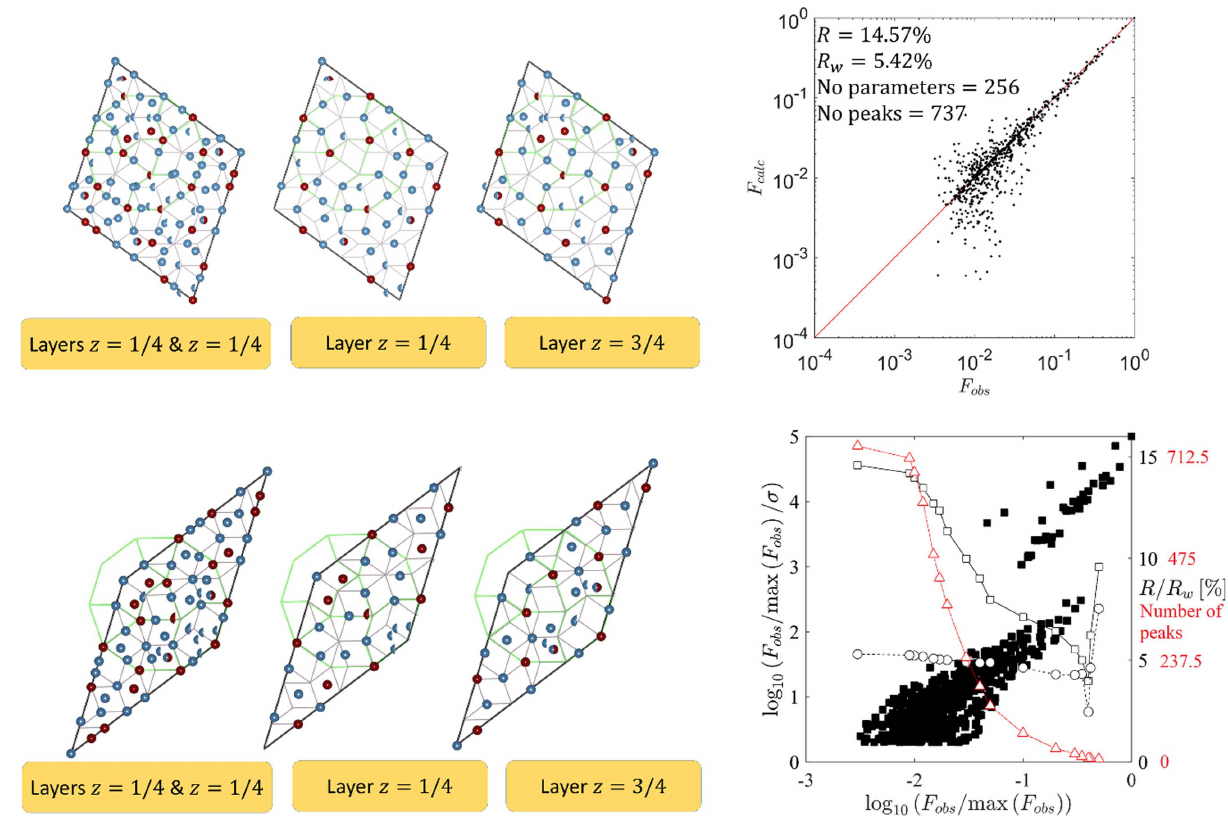
Figure 7 Refined atomic decoration for each type of rhombi in the RPTand every atomic layer. The color coding is the same as in Fig. 6 with an addition of a red half-sphere defining the partially occupied TM site. The basic 2.45 A˚ RPT is plotted within every rhombus confirming the positions of atoms follow the specific sites of rhombi. The Gummelt cluster is plotted for guidance. The correlation plot F calc versus F obs shows good agreement of the model with experimental data. The distribution of diffraction peak errors shows a two-domain behavior. The value of the R factor (standard and weighted) decreases with the decreasing number of weak reflections taken for